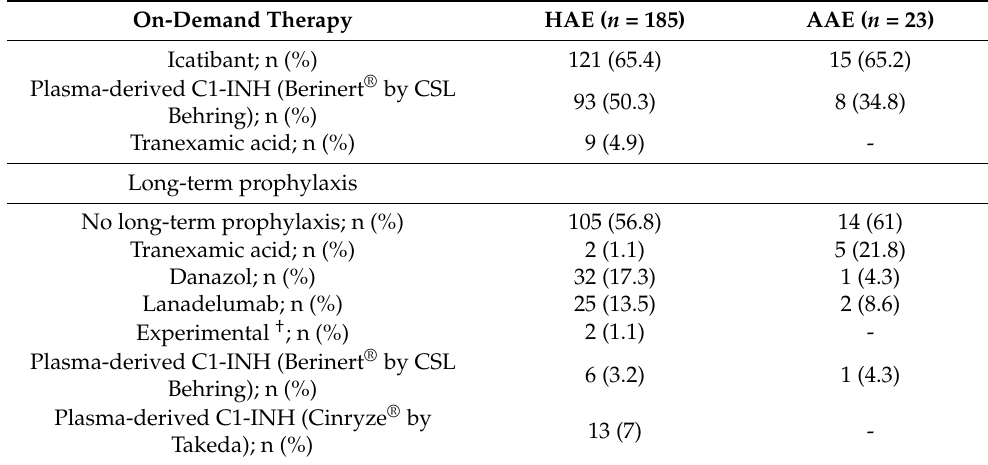
Table 2. On-demand therapies and long-term prophylaxes used by the patients before the primary vaccination